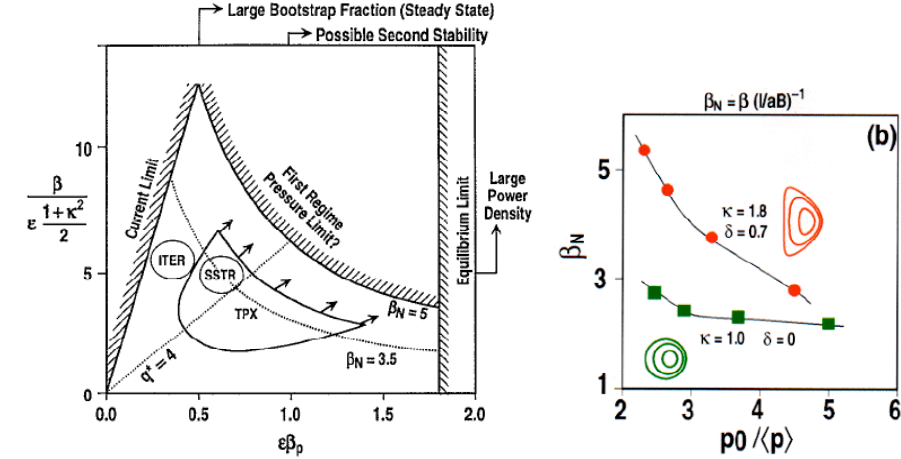
Figure 18. Advanced tokamak operating regime (left) and shape and profile effect on normalized beta (right)